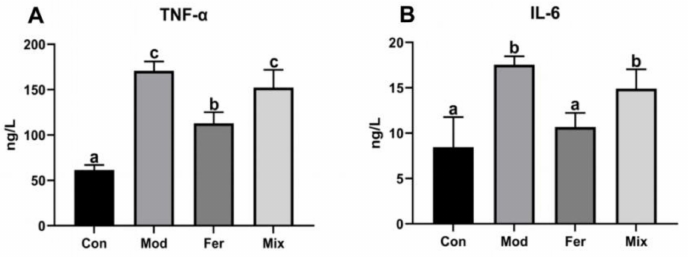
Figure 5. Serum levels of TNF- α ( A ) and IL-6 ( B ). Serum of rats was collected at the time of execution, and the levels of TNF- α and IL-6 were measured using ELISA kits. Values are expressed as mean ± SD (n = 6). With p < 0.05, values with various superscript letters differ